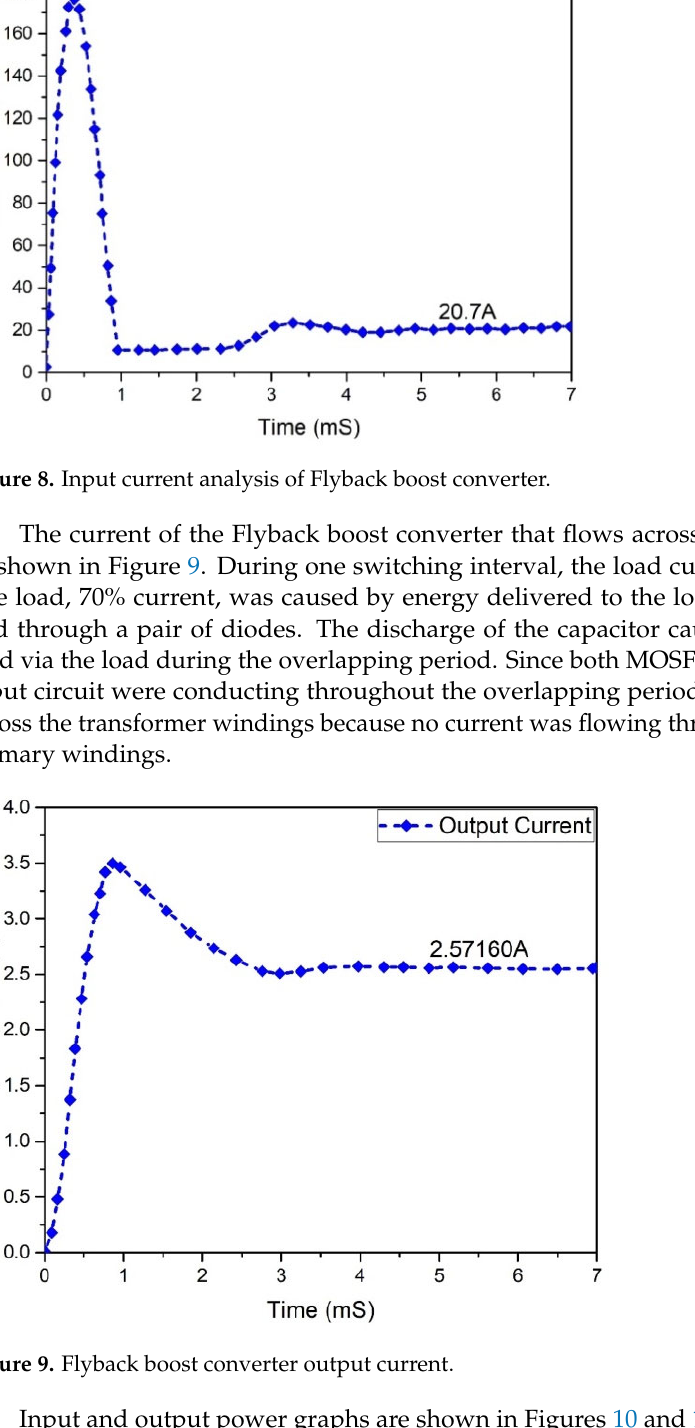
Figure 7. Flyback boost converter output voltage.